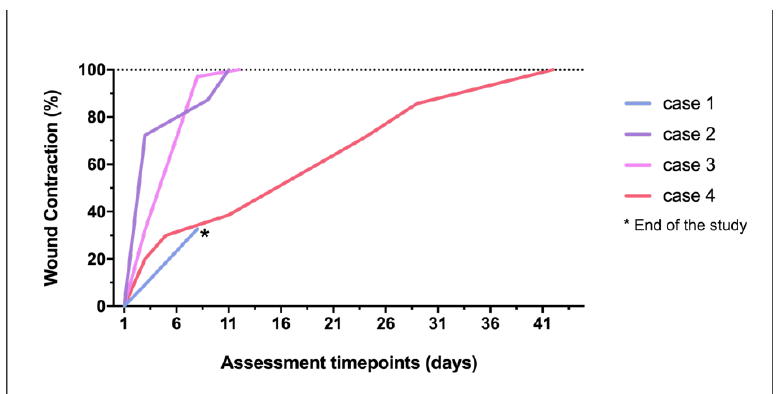
Figure 7. Wound contraction percentage achieved in each lesion through the study.